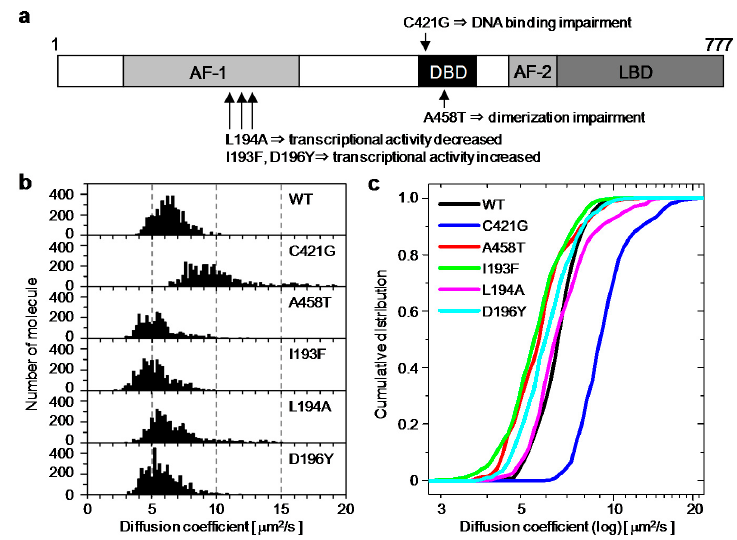
Figure 3. The histograms and cumulative distributions of diffusion coefficients for EGFP-hGR wild type and mutants: ( a ) The functional domain of the glucocorticoid receptor and the position of the mutations; ( b ) the diffusion coefficient histograms of hGR wild type and mutants were constructed by integrating the numbers which were calculated by one-component fitting analysis of each brick in the diffusion map ( n = 6–8 cells); ( c ) the cumulative distributions constructed from the diffusion coefficient histograms of hGR wild type and mutants. Table 1. Diffusion coefficients of hGR wild type and mutants.